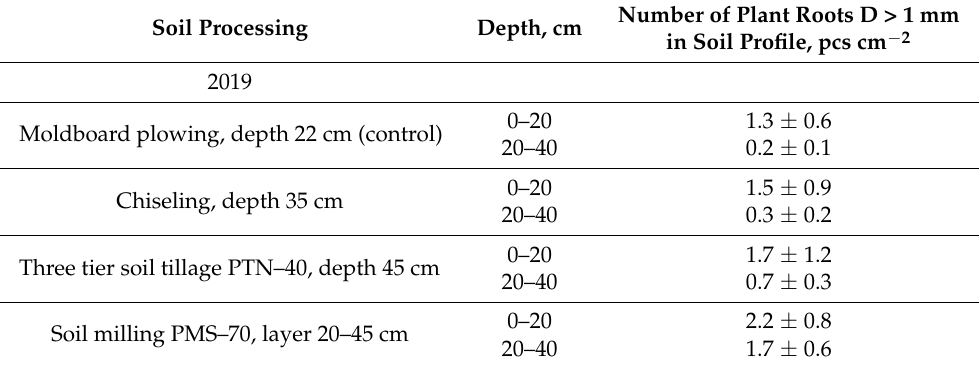
Table 5. Root development after different options of soil mechanical